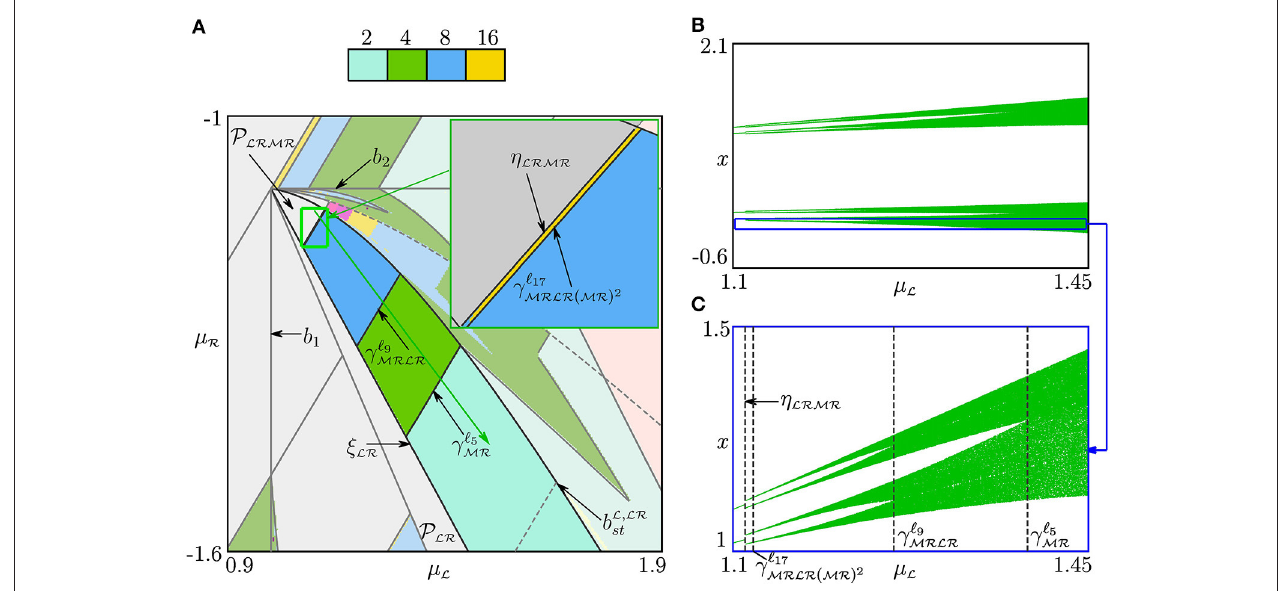
FIGURE 12 | (A) Bifurcation structure of the region D L , LR st . Bifurcation diagram (B) along the arrow shown green in (A) and its enlargement (C) .